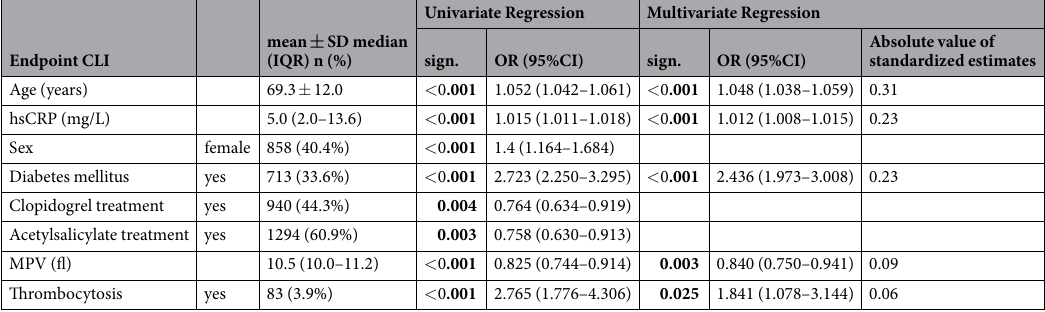
Table 2. Significant predictors for CLI. Abbreviations: CLI, critical limb ischemia; MPV, mean platelet volume; sign., significance, hsCRP, high sensitive c-reactive